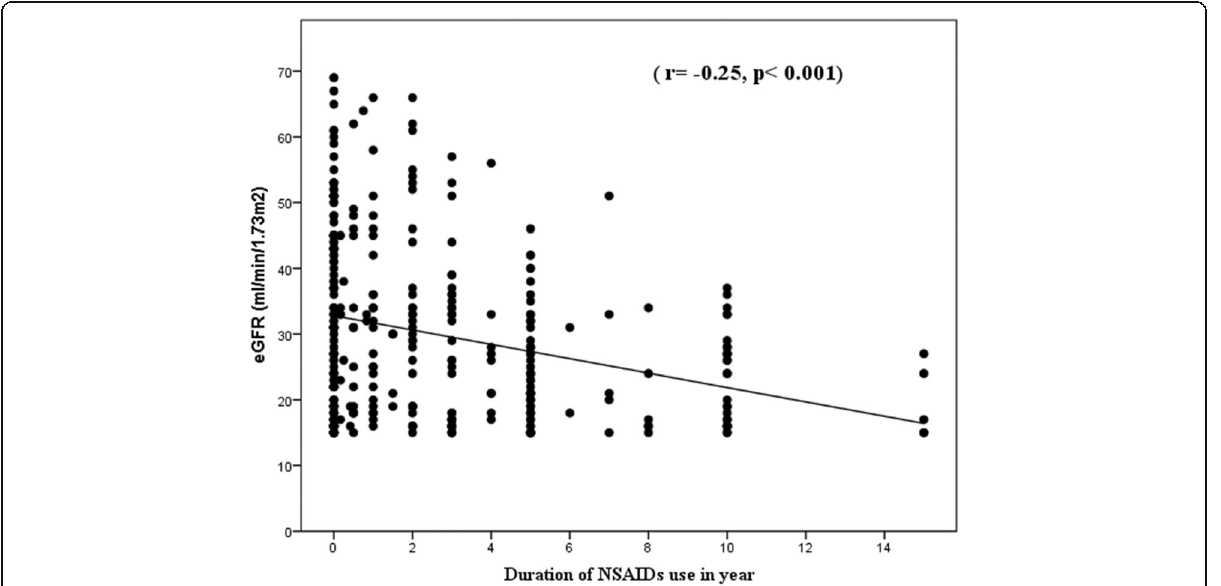
Fig. 2 Correlation between the duration of NSAID use and eGFR